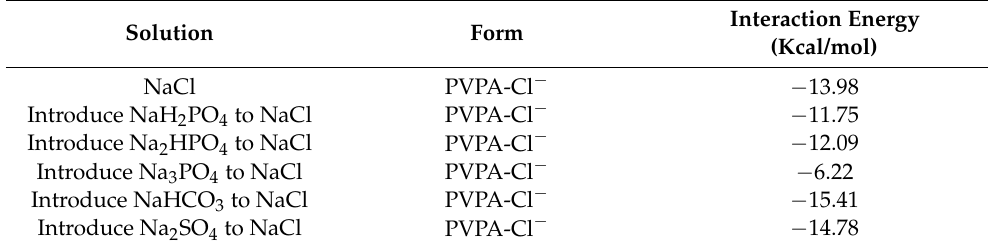
Table 2. Calculated interaction energies of the PVPA chain with Cl - before and after the introduction of